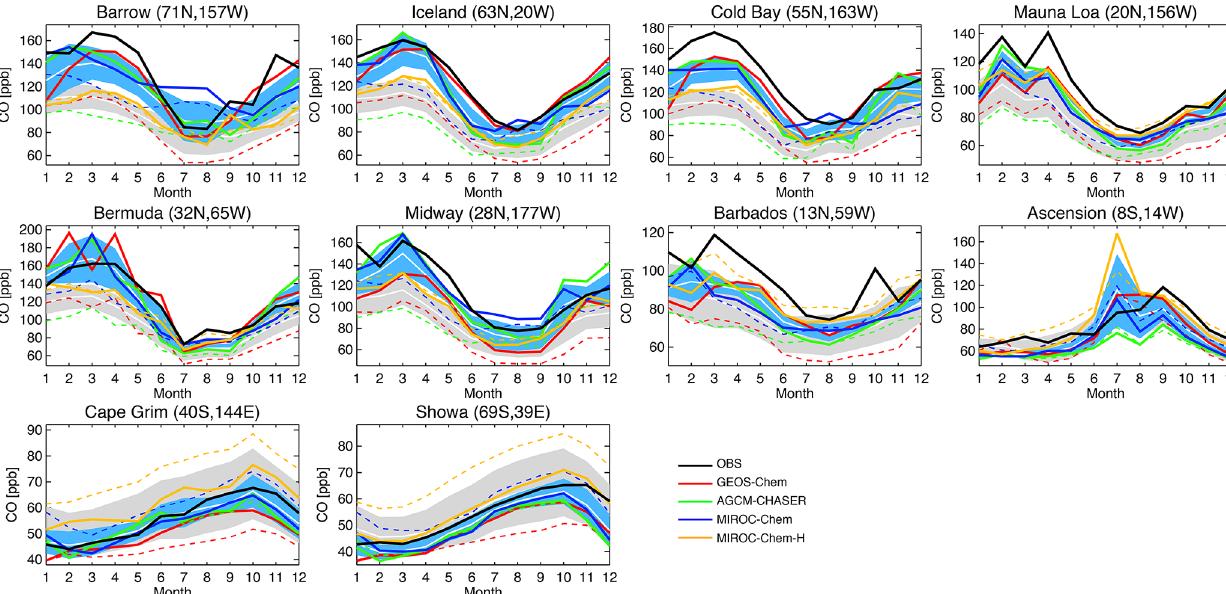
Figure 11. Time series of monthly mean surface CO concentrations (ppbv) from the WDCGG observations (black solid line), control runs (colored dotted lines), and data assimilation analyses (colored solid lines). The ± 1 σ deviation among the four models (i.e., model spread) is shown in gray for the control runs and in light blue for the data assimilation results.